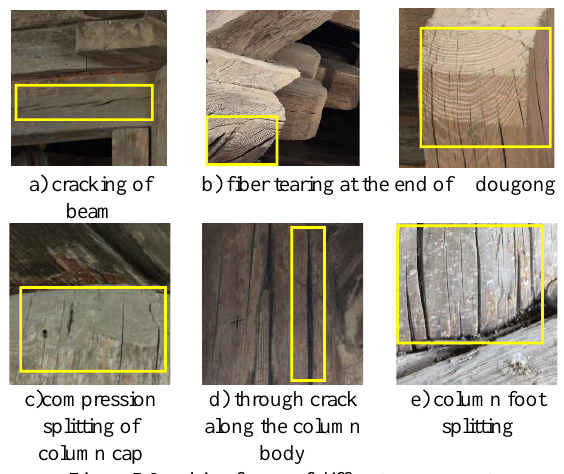
Figure 5.Cracking forms of diffrent components